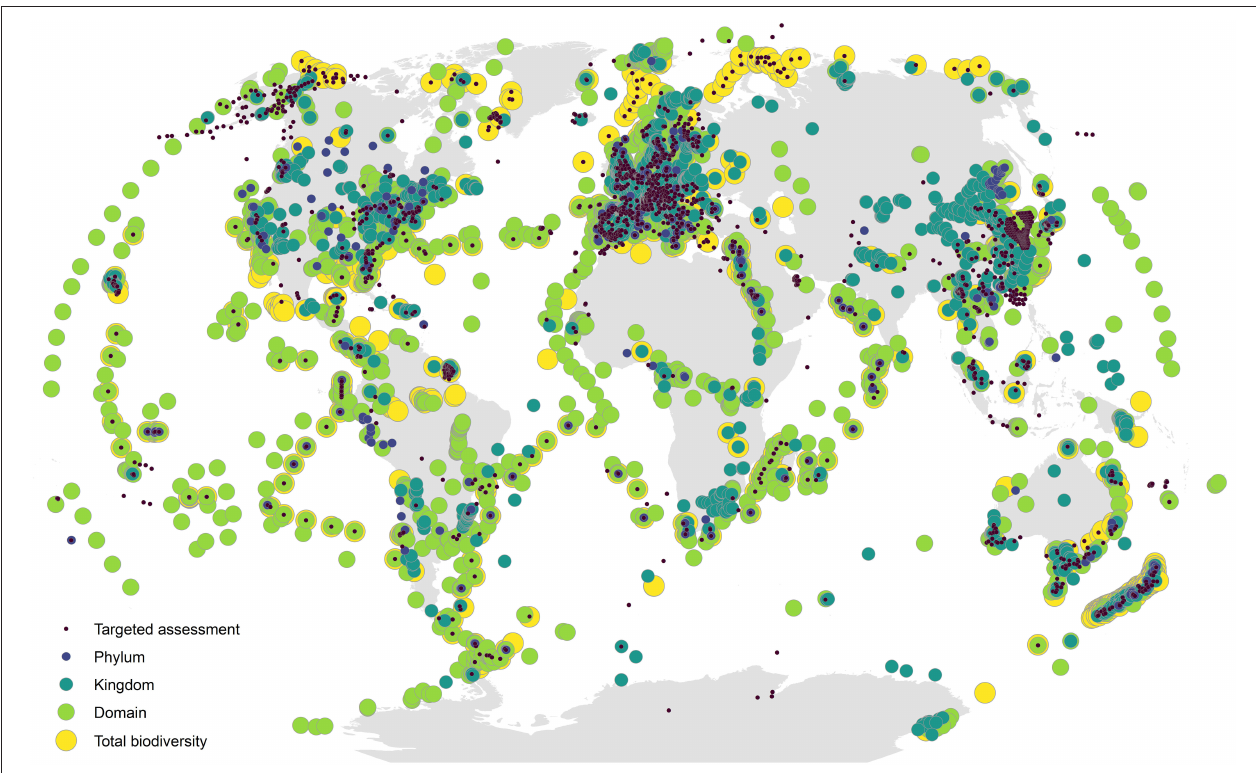
FIGURE 2 | Global map of metabarcoding sampling locations. Points are scaled and colored by the breadth of biodiversity covered, ranging from targeted assessment (class level or below) to total biodiversity assessment (samples using broad-coverage primers covering two or more domains). Data come from a systematic literature search of 1,563 published articles on DNA metabarcoding ( Supplementary Material 1 ); for methodological details, see Supplementary Materials 2, 3